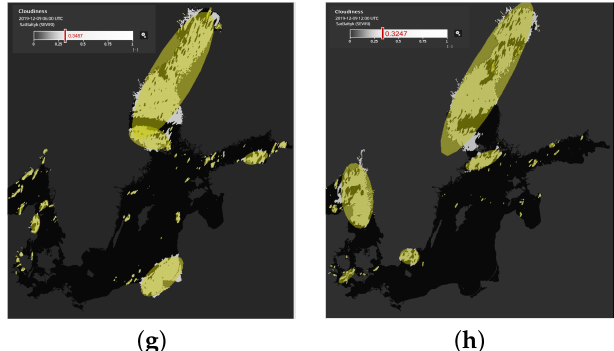
Figure 3. Results of the different cloud detection methods based on an satellite image 09/Decem- ber/2019 6:00 UTC + 01:00 and 12:00 UTC + 01:00 normalized to the SatBaltic format. Maps of ( a ) inverse radiation temperature based on set A.1 and ( b ) reflectance set A.2 (white and degrees of grey—clouds, dark grey—sea, black—land), ( c , d ) application of the conventional detection technique + moment-assisted method, ( e , f ) the Otsu + moment-assisted method, and ( g , h ) the supervised + moment-assisted method (yellow-white—area defined equally as cloudiness by both methods, yellow-black—overestimated area (not defined equally and as cloudiness by the first method); white— underestimated area (not defined equally and as cloudiness by the method of moments), black—area correctly detecting no cloudiness, and grey and